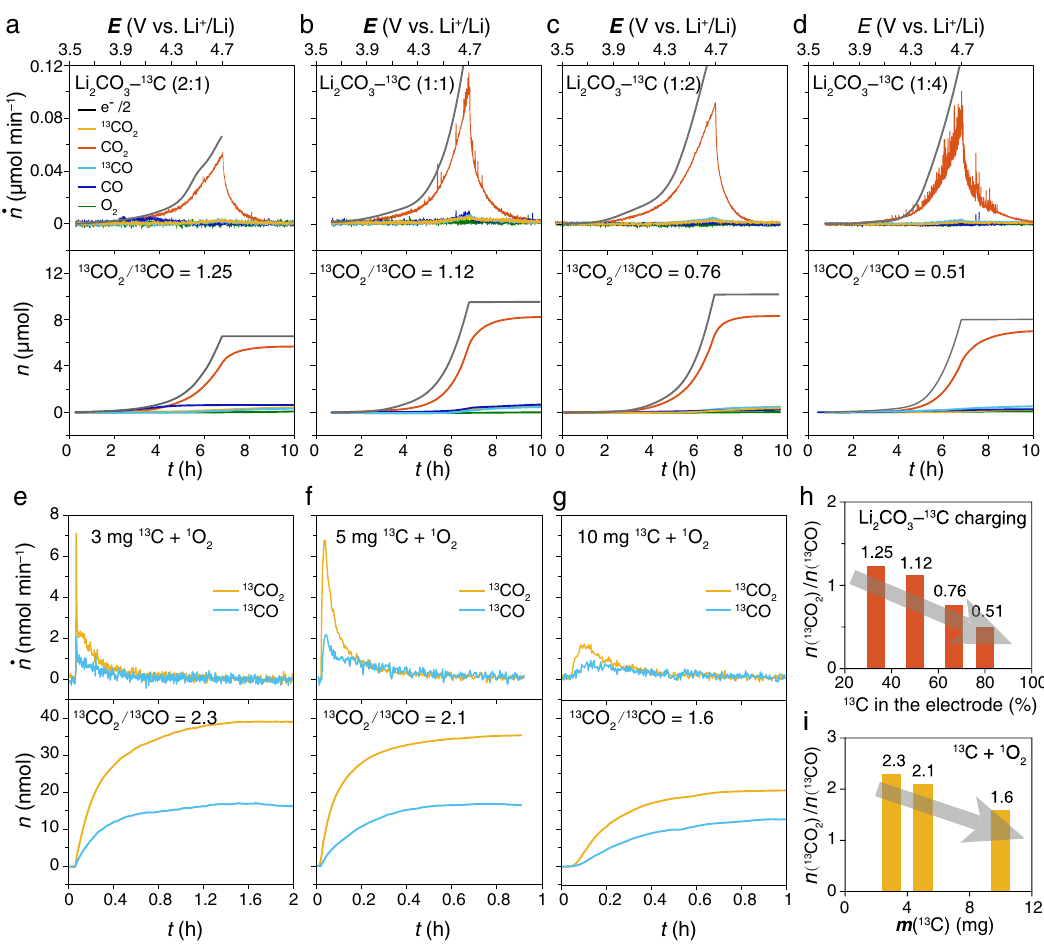
Fig.3|Incompleteoxidationof 13 C-carbonbysingletO 2 toform 13 COand 13 CO 2 . a – d Thegas evolutionduring the charging processofthecellsusing theLi 2 CO 3 - 13 C compositeelectrodeswithvariousmassratiosofLi 2 CO 3 / 13 C, a 2:1, b 1:1, c 1:2, d 1:4in 1MLiTFSI-tetraglyme. e – g 13 CO 2 and 13 COevolutionoftheexsituchemicalreaction between singlet O 2 and 13 C-carbon in tetraglyme solution. 22mg KO 2 powder was